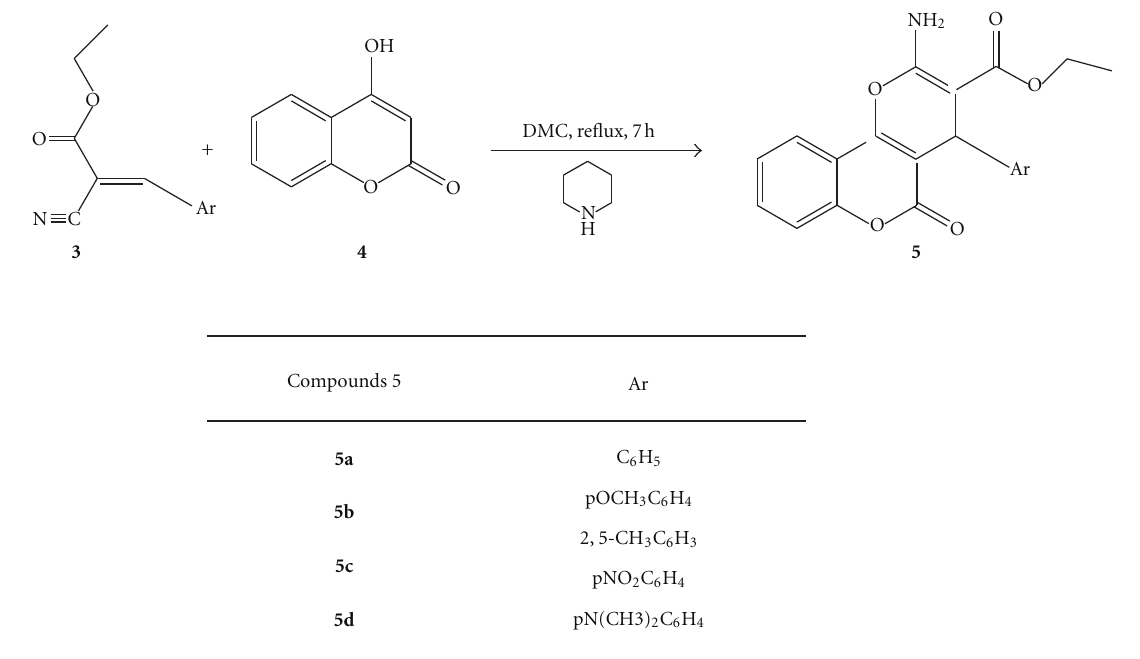
S 2: Synthesis of 2-amino-3-ethoxycarbonyl-4-(aryl)-4H-pyrano-[3,2-c]-chromene-5-ones 5 .